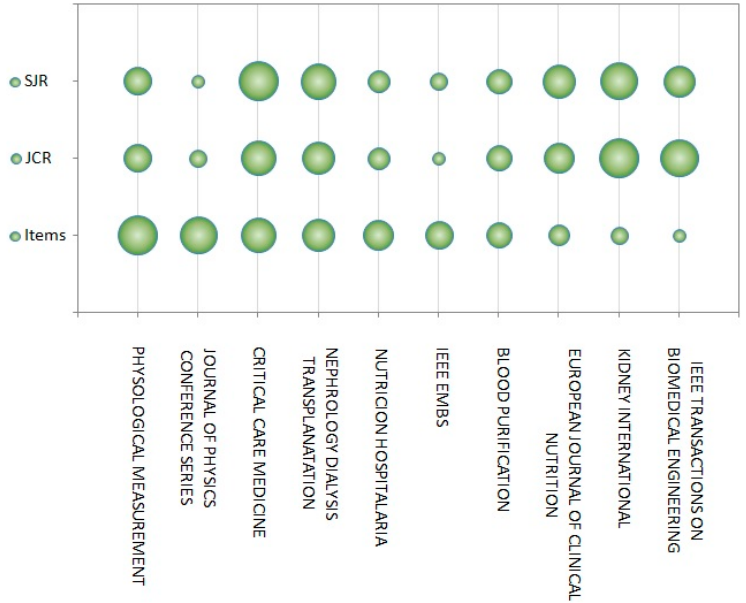
Figure 10. Ranking of top 10 dielectric journals according to items, JCR (Journal Citation Reports) and SJR (Scientific Journal Rankings) criteria.